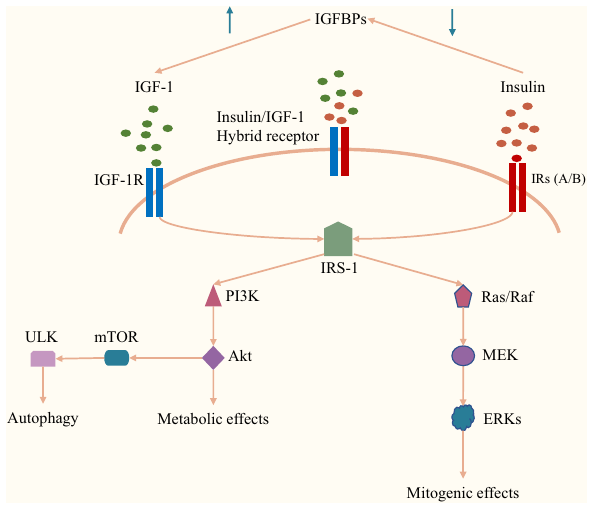
Fig. 1 Insulin signaling and crosstalk with the IGF-1 systems. Insulin regulates the Ras/Raf/MAPK and PI3K/AKT/mTOR pathways to influ- ence the development of BTC. In the condition of hyperinsulinemia, insulin can directly bind to IGF-1R and IR/IGF-1Rs or indirectly increase the biologically active free IGF-1 to augment its mitogenic and antiapoptotic effects. IGF-I insulin-like growth factor-1, MAPK mitogen- activated protein kinase, PI3K phosphatidylinositol-3-kinase, Akt protein kinase B, mTOR mammalian target of rapamycin, BTC biliary tract cancer, IGF-1R insulin-like growth factor-1 receptor, IR/IGF-1Rs hybrid receptors of insulin receptor and insulin-like growth factor-1 receptor, IRS insulin receptor substrates, IRs(A/B) insulin receptor A or B isoform, IGFBPs insulin-like growth factor-binding proteins, ULK Unc-51 like autophagy activating kinase, MEK mitogen-activated protein kinase kinase, ERK extracellular signal-regulated